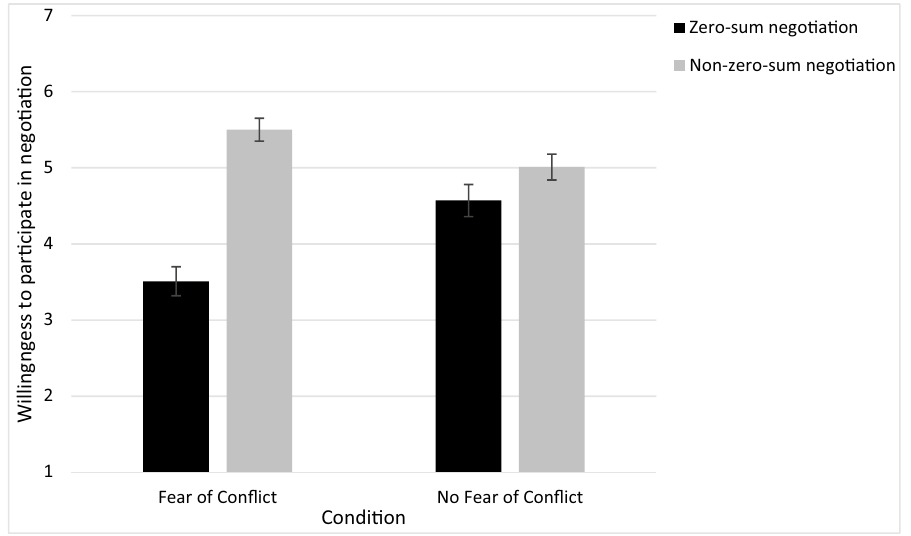
Figure 3. Participants’ willingness to participate in a zero-sum and a non-zero-sum negotiation as a function of their fear of conflict (Study 5A). Errors bars represent standard errors